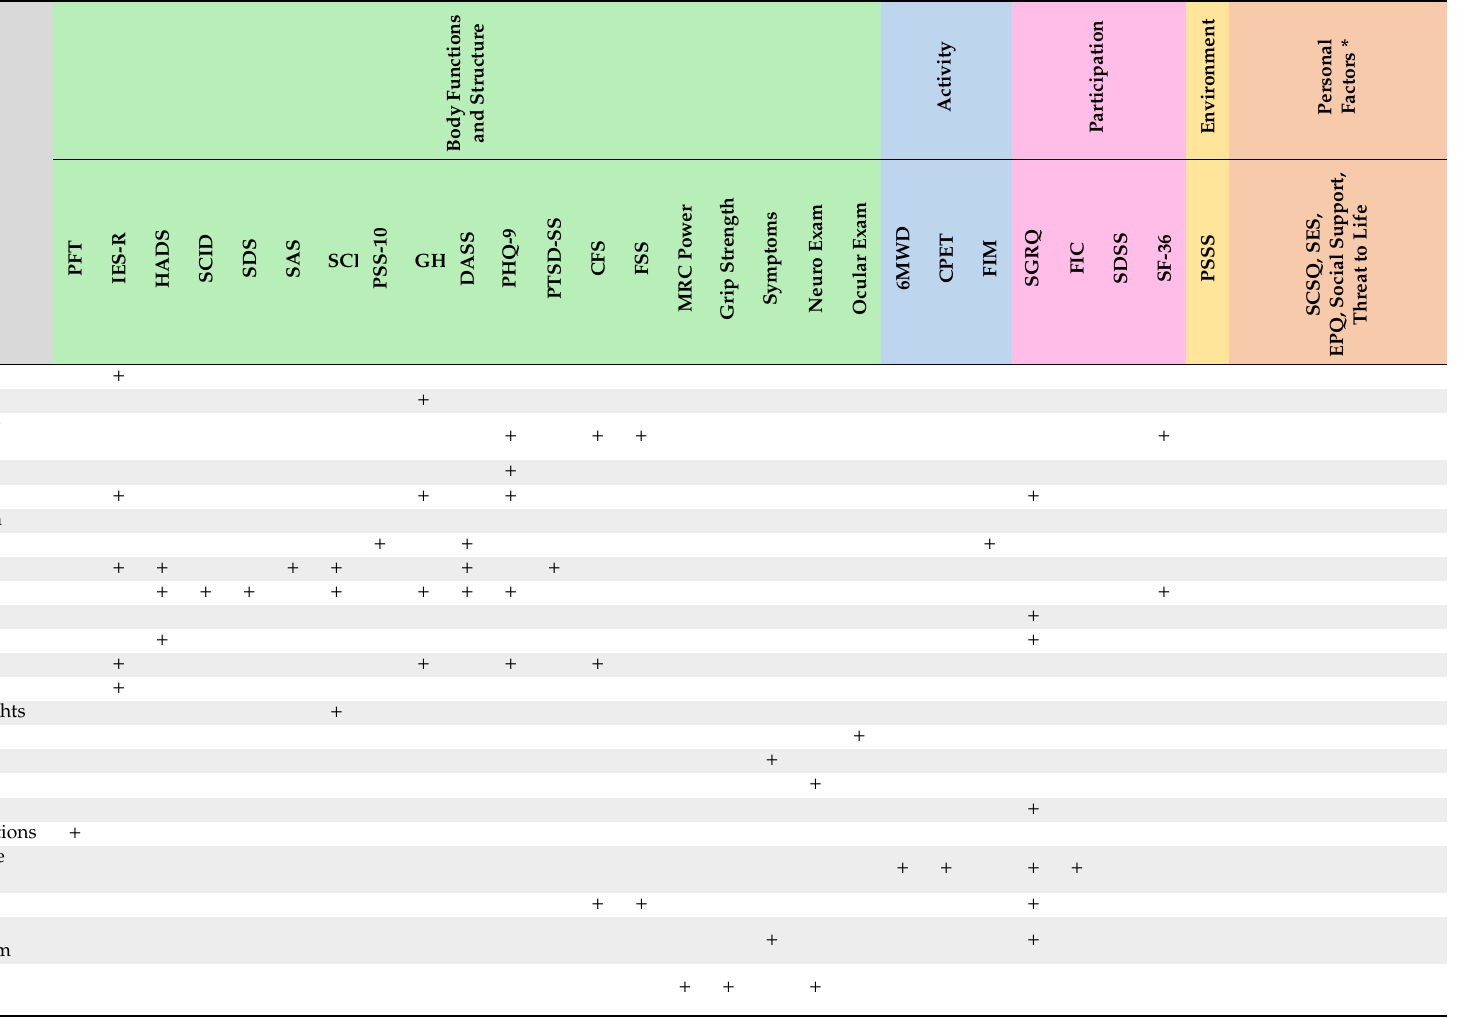
Table 3. Mapping of outcome measure themes to ICF category